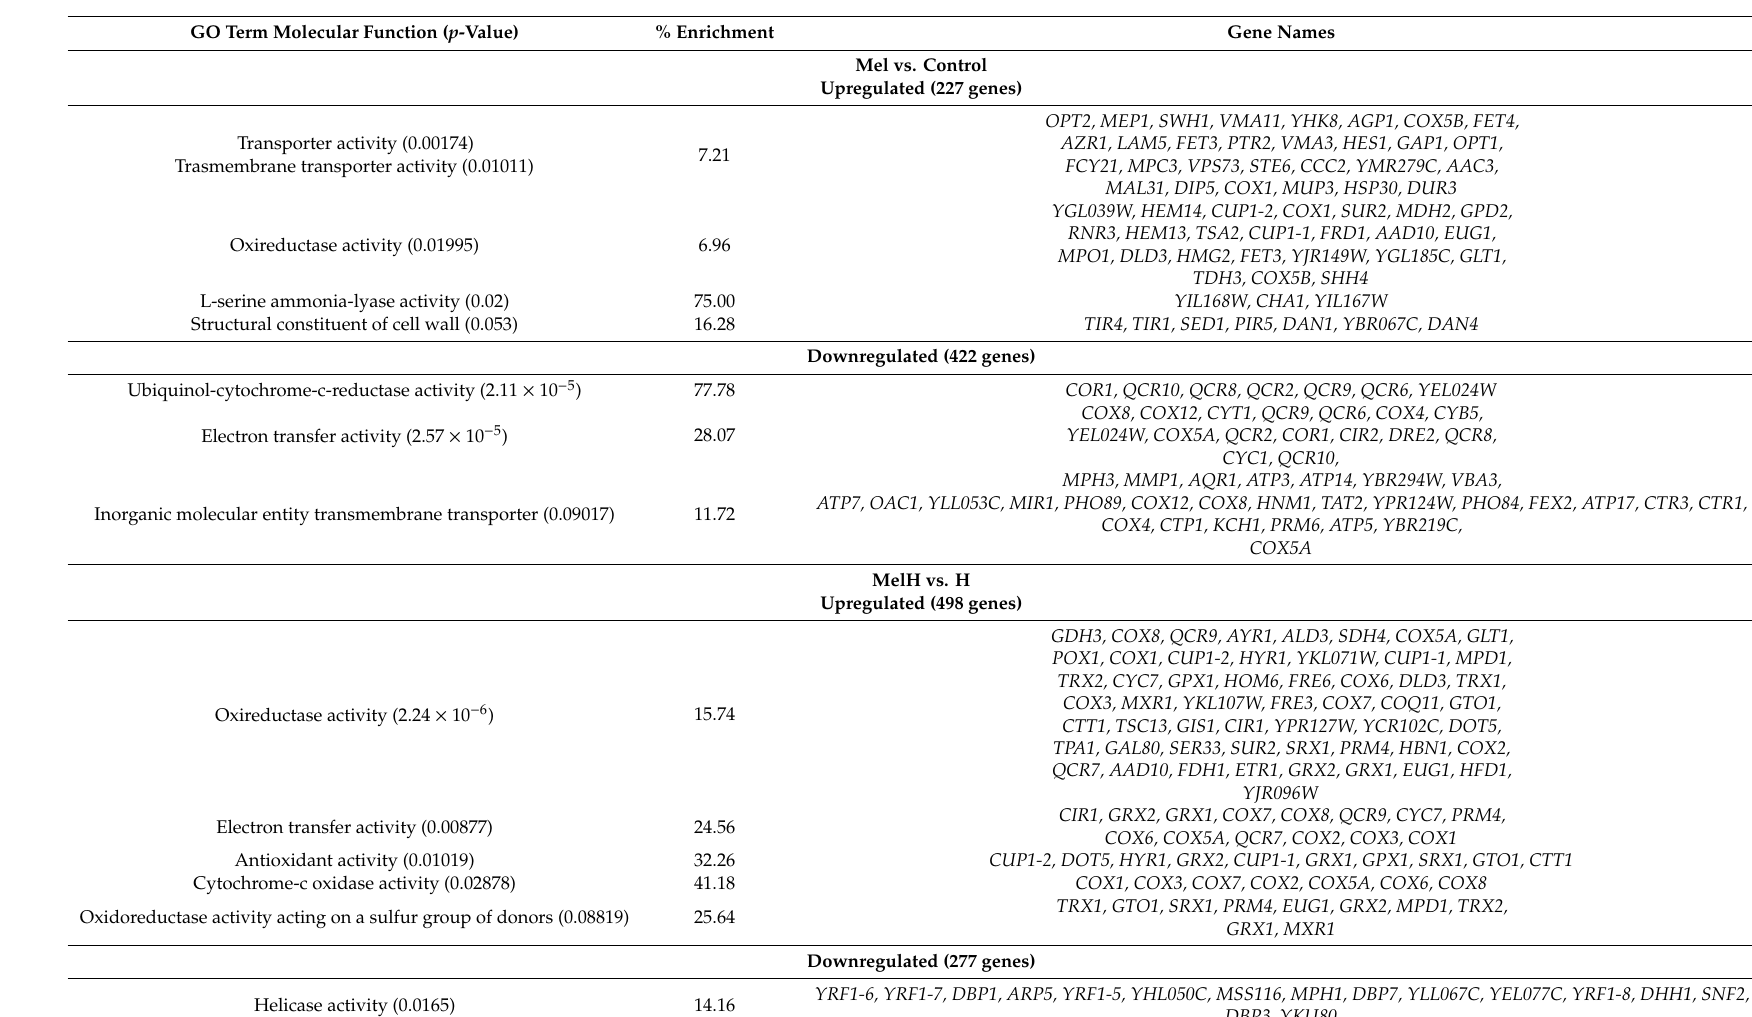
Table 2. Molecular function enrichment according to the Gene Ontology (GO) analysis of di ff erentially expressed genes that were up- or downregulated (fold change ≥ 1; p -value < 0.05) among nonstressed and stressed (2 mM H µ M) (Mel vs. Control, MelH vs. H). Percentages of 2 O 2 ) cells in the absence or presence of melatonin (5 enrichment are calculated as the ratio of the number of up- or downregulated genes in relation to the total genes involved in each molecular function in S. cerevisiae . GO Term Molecular Function ( p